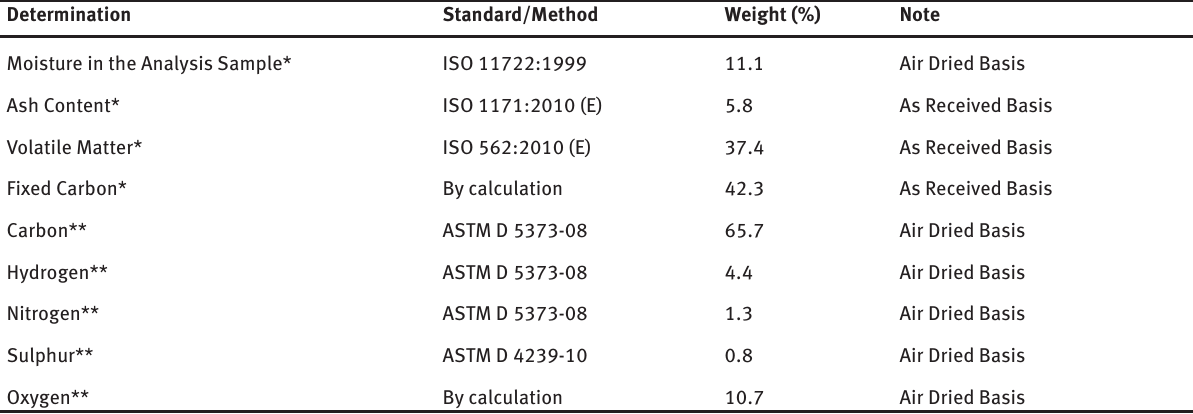
Table 1: Compositional data of the coal (* Proximate Analysis ** Ultimate Analysis)